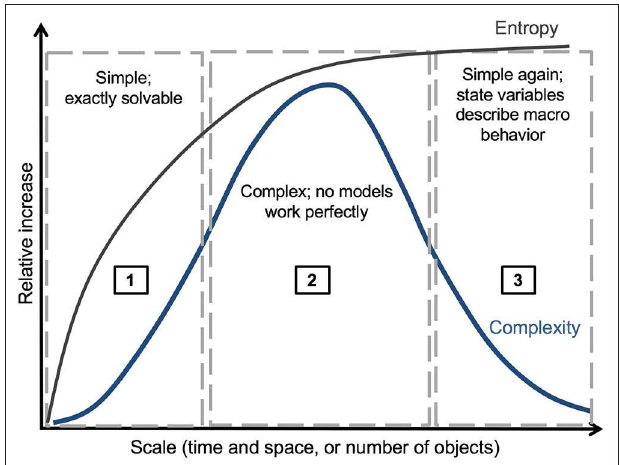
FIGURE 2 | Schematic relationship between entropy and complexity. Entropy increases monotonically with increasing scales of physical systems, whereas complexity increases from (1) the region of fundamental physical models, (2) to the “middle-number domain,” but then decreases (3) as large systems are described adequately by aggregate properties. In region (1), models are deterministic and exactly solvable. In region (2), complex behavior of the system is controlled by interacting top-down and bottom-up processes, and models therefore will not provide perfect predictions of data. In region (3), statistics are highly aggregated for large numbers of interacting elements, and general laws emerge (for example, the Ideal Gas Law, the species area relationship in macroecology, or annual wildfire burned area at subcontinental scales).